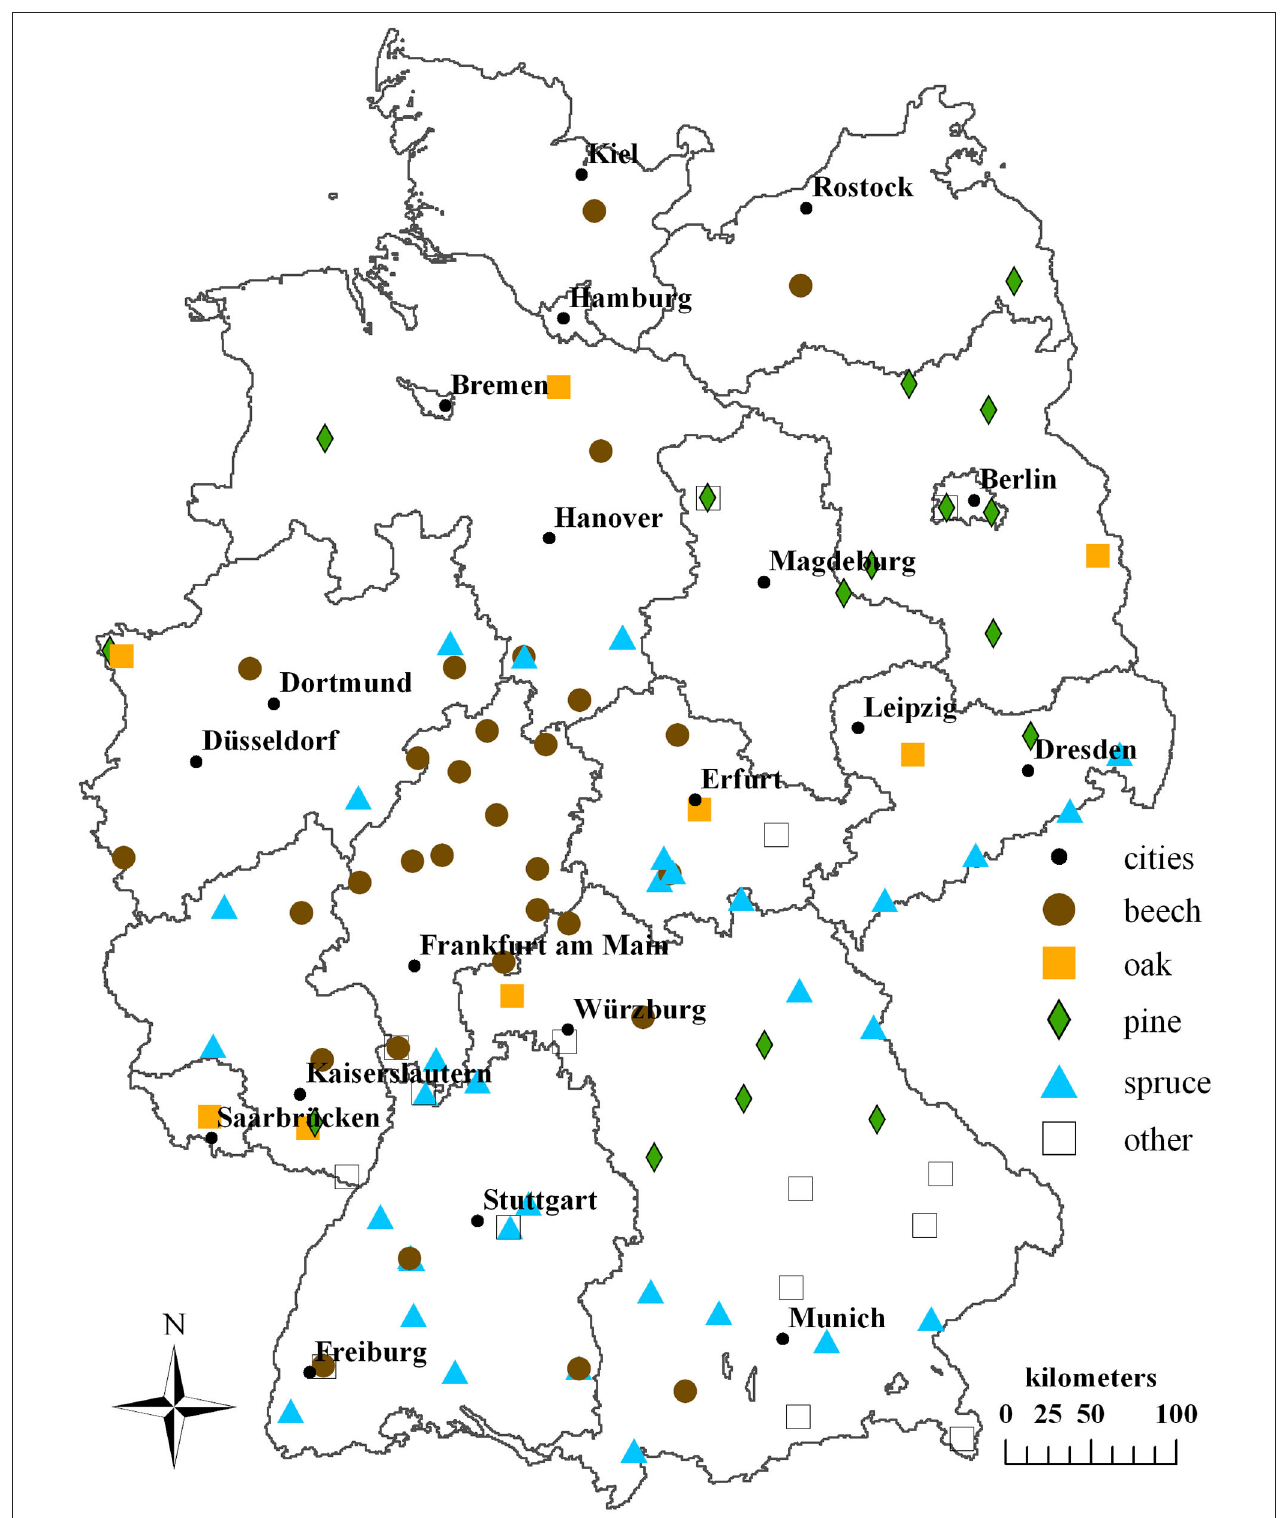
FIGURE 1 | Location of 104 German intensive monitoring plots considered in the study. Symbols representing beech, oak, spruce and pine dominated forest sites and sites with other trees (Douglas fir, larch, mixed forest).